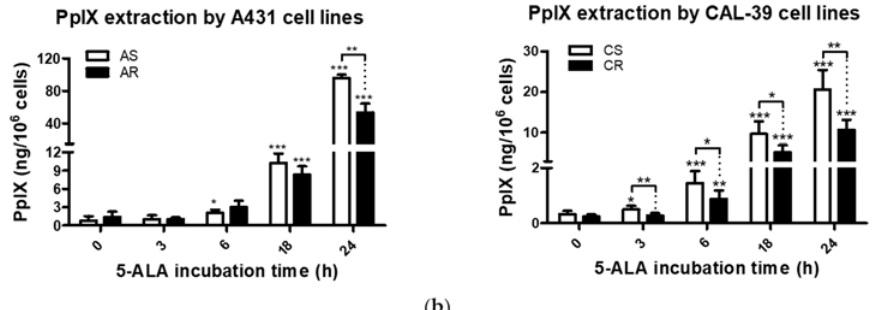
Figure 3. PpIX accumulation and extraction. ( a ) PpIX levels in A-431 and CAL-39 cell lines. ( b ) PpIX levels in culture media collected from above A-431 and CAL-39 cells. The amount of PpIX was calculated from standard curve and presented in ng per 10 6 cells. Asterisks indicate statistical significance of differences between untreated cells and cells incubated with ALA for various periods of time, or the sensitive and resistant cells calculated by Student’s t -test (* p ≤ 0.05, ** p ≤ 0.01, *** p ≤ 0.001).